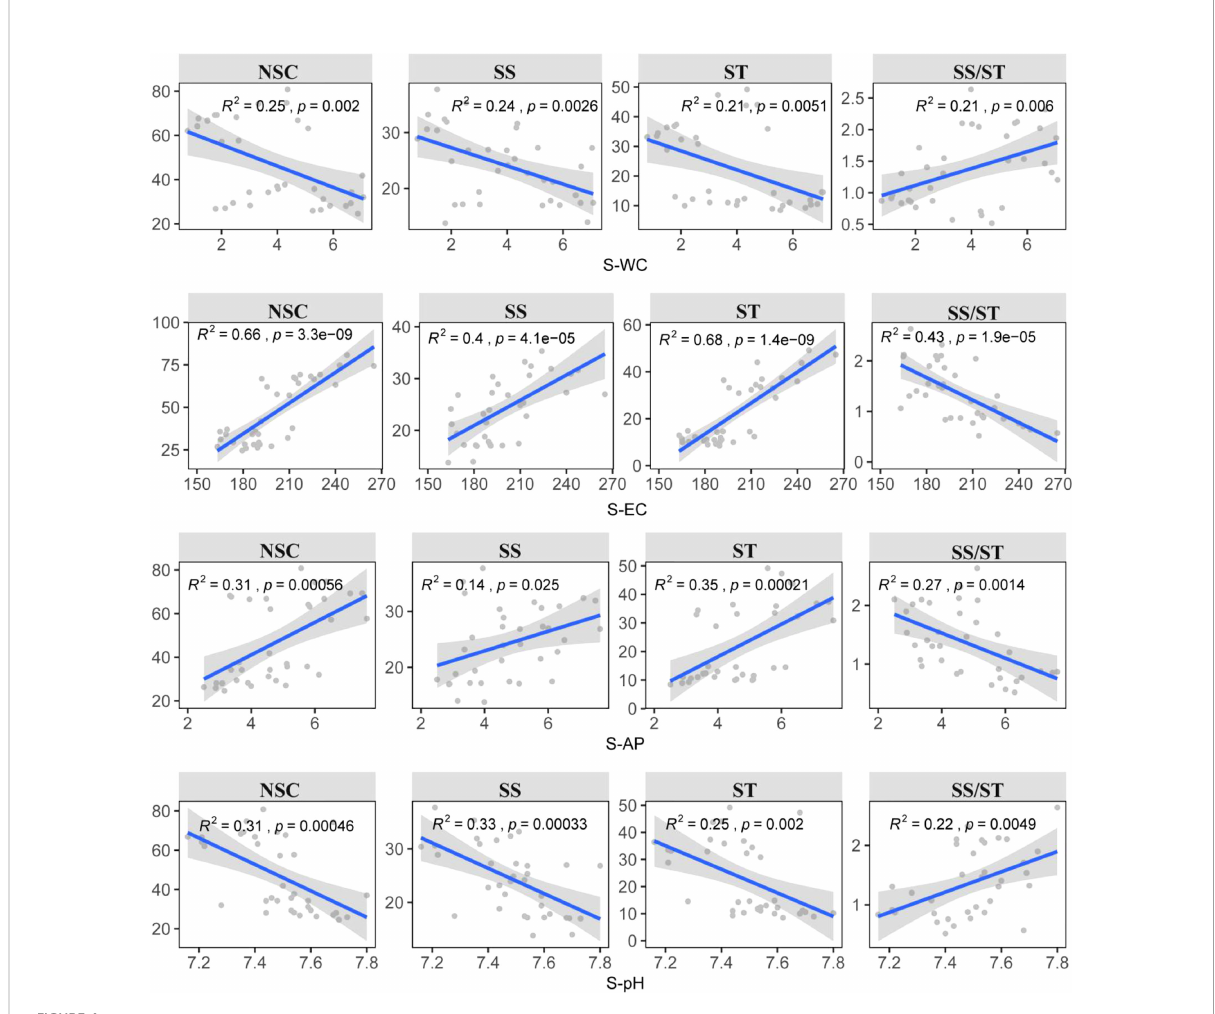
FIGURE 4 Relationships between the NSC and its components of Syntrichia caninervis and the main drivers were estimated via linear least ‐